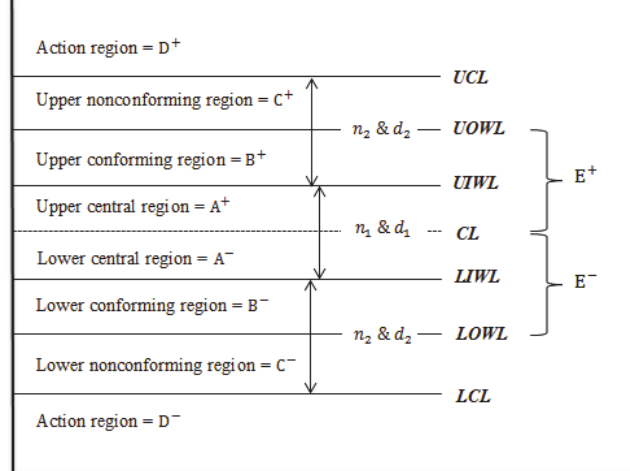
Fig. 1. The control and warning limits and the corresponding regions of the VSSI-Synth and VSSI- Runs 𝑋 (cid:3364)